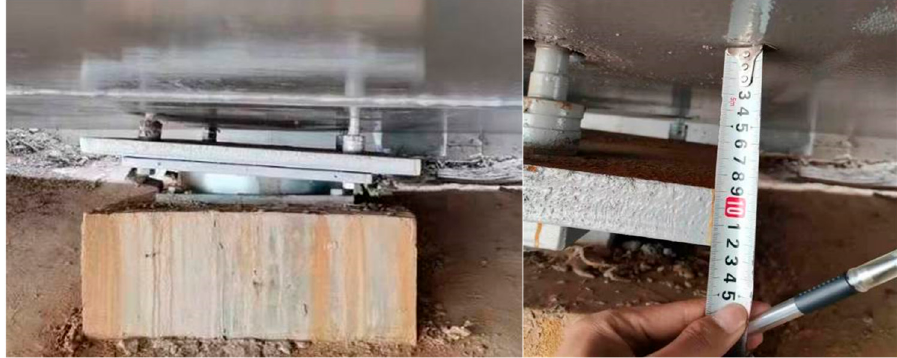
Figure 5. Top pipes of the frame scaffolding failed after the typhoon.